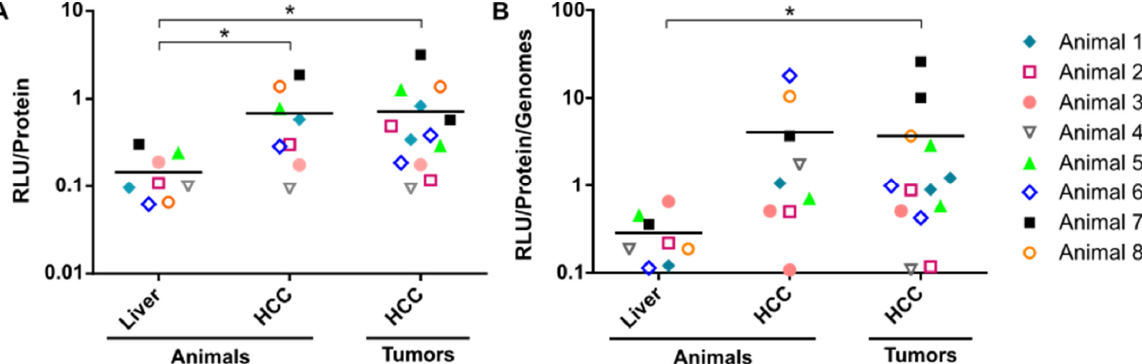
Figure 2. Transduction efficiency of AAV2 vector in liver and HCC of the TGFα/c-myc HCC mouse model. Tumor-bearing mice received scAAV2.SFFV.Fluc and scAAV2.CMV.eGFP. Vector dose: 2 × 10 11 particles per vector per animal. ( A ) Transgene expression was analyzed by luciferase assay quantifying luciferase activity in liver and HCC 96 h after administration of the first vector (scAAV2.SFFV.Fluc). As outlined above, animals had been first i.v. injected with scAAV2.SFFV.Fluc and 12 h later with scAAV2.CMV.eGFP. Luciferase activity is shown in relative light units (RLU) normalized to the total protein content of tissue lysates in µg. ( B ) Transgene expression index determined by correlating RLU (normalized to protein content) and relative vector genomes (normalized to ng DNA; see Figure 1). Data for ( A ) and ( B ) are shown in log 10 -scale and as mean units per animal (liver and HCC tissue), as well as mean units per individual tumor sample ( n = 1–2 tumor lesions per animal compared to respective liver sample), together with the grand mean within each cohort. Samples belonging to the same animal are labeled by the same symbol. Statistics: Cohort sizes account for the Shapiro–Wilk normality test ( p < 0.0001); Shapiro–Wilk normality test with log 10 -transformed data (not significant (ns)); ordinary one-way ANOVA with log 10 -transformed data (( A ): p = 0.0121; ( B ): p = 0.04) and Dunnett’s multiple comparison test with “Liver” as control cohort; * p < 0.05. N = 8 animals.